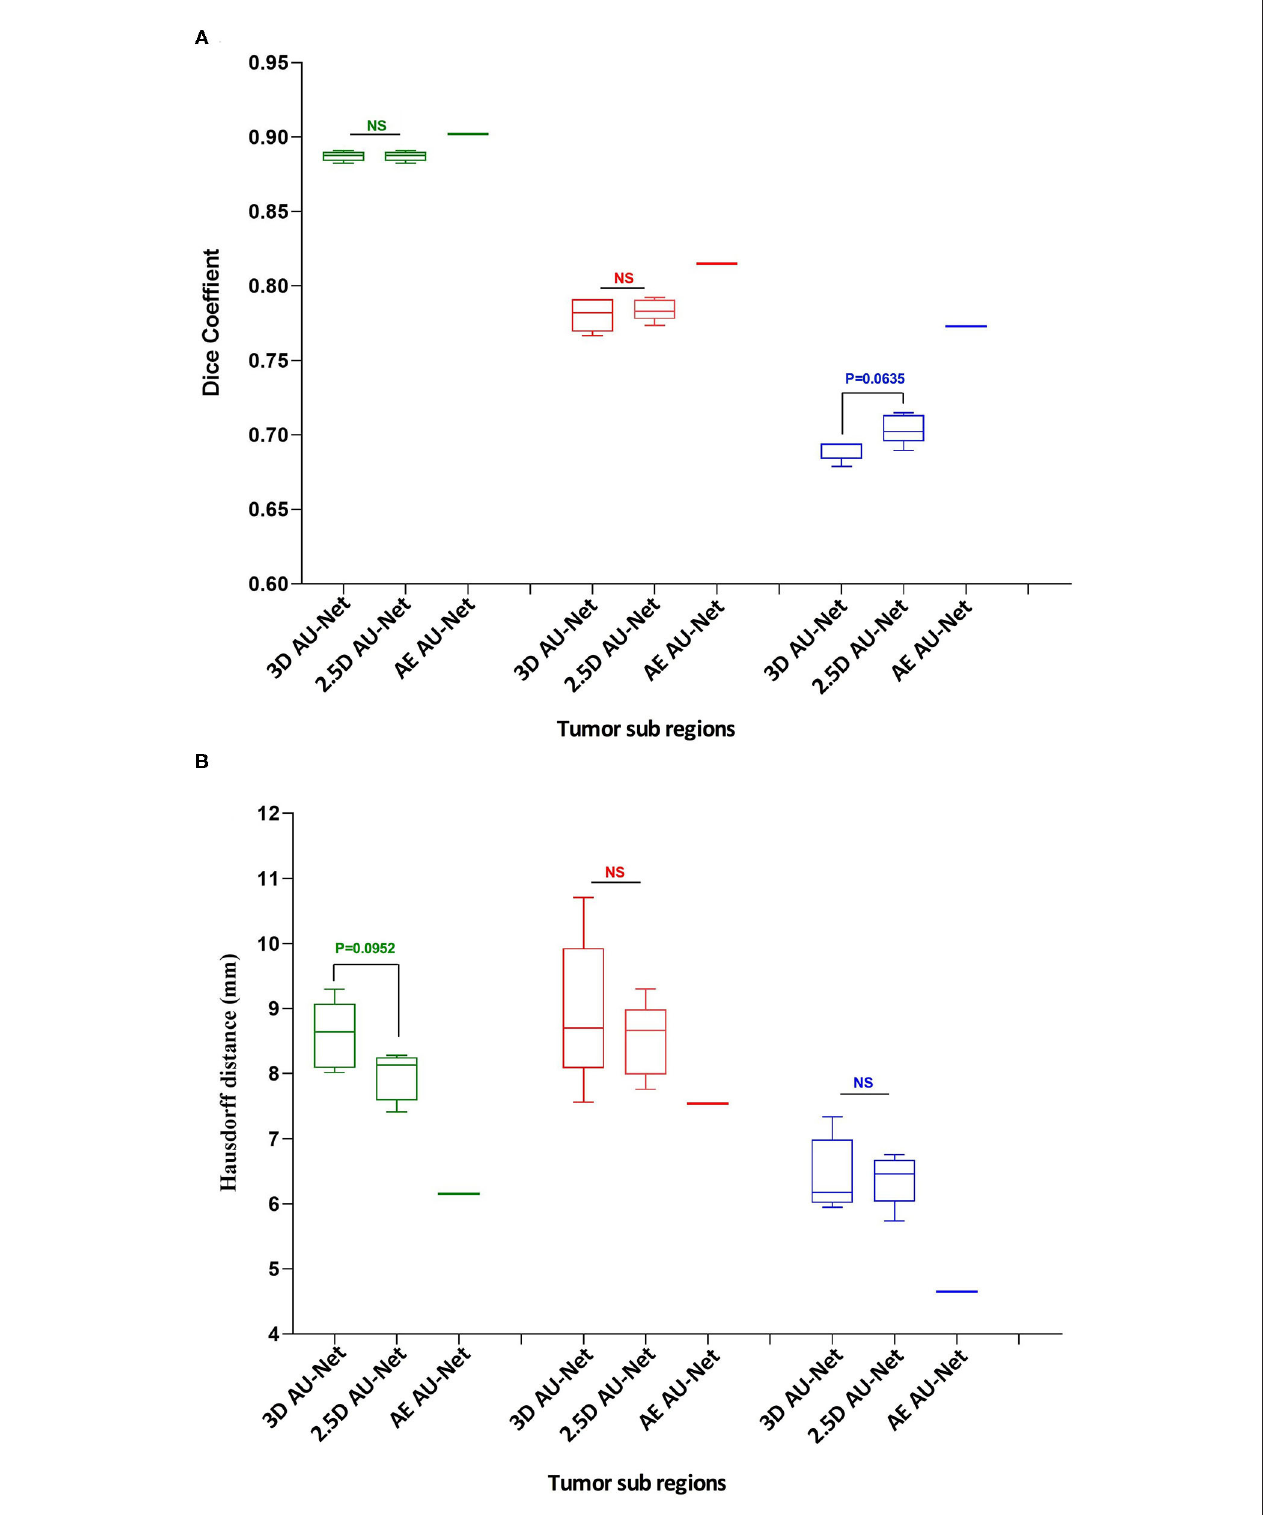
FIGURE 6 | Quantitative results. Box plot comparing two models in a 5-fold cross-validation: the 3D Asymmetric U-Net, the 2.5D Asymmetric U-Net, and the impact of our proposed model (AE AU-Net). (A) The y -axis presents the Dice score values for the three tumor sub-regions in the x -axis. (B) The y -axis shows the Hausdorff distance for the three tumor sub-regions in the x -axis. In green, red, and blue are depicted the three tumor sub-regions: whole tumor, tumor core, and enhancing tumor. The third column corresponding to our AE AU-Net is not a box plot; it is a single value obtained with the ensemble for comparison purposes.